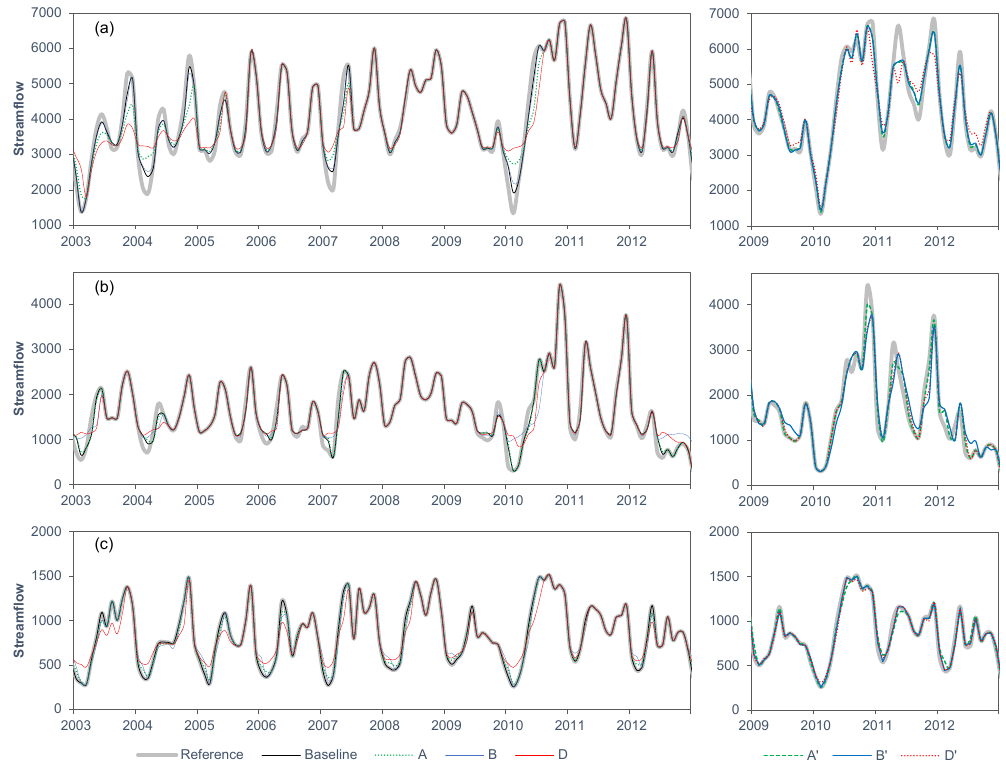
Figure 10. Comparison of 10-year sample (2003–2012) of simulated boundary conditions (monthly average streamflow) resulting from selected hydropower configurations A, B and D. Streamflow values are shown for stations on the (a) Magdalena (2502733), (b) Cauca (2624702), and (c) Nechí (2703701) rivers, upstream of the Mompós Depression. Full period of boundary conditions is 1981– 2013. Left plots show resulting simulation from scenarios from a hydropower priority operation. Right plots show examples of operation aiming to reduce flood peak magnitudes during the Niño–Niña 2009–2011 event by maintaining low storage in reservoirs to regulate peak